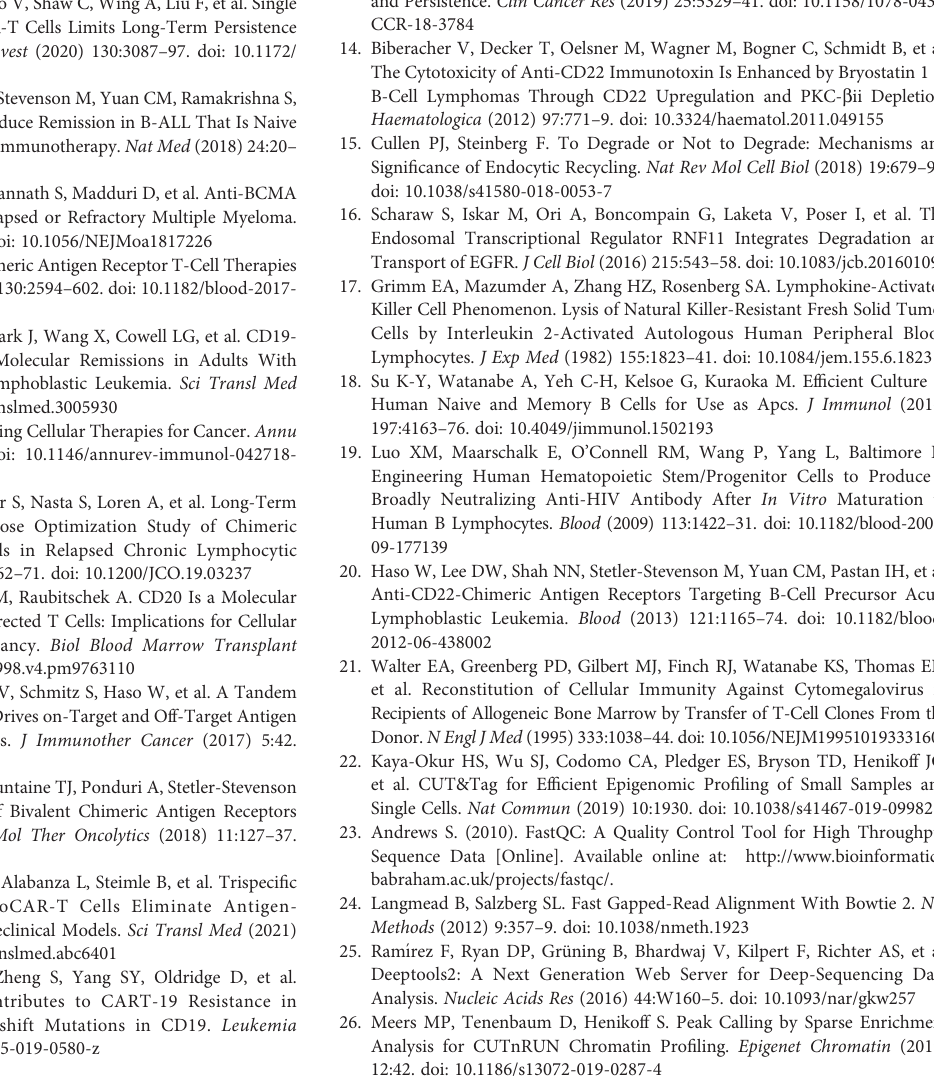
signal from Cut&Tag analysis and the second tab lists differential expression between bryostatin-treated and control (non-treated) leukemia cells. The global tab contains the peak ID (column A), chromosome (column B), start and end sequence number (C,D), annotation (E), distance to transcription start site (TSS) (F), gene name (G), gene description and type (H,I). Signal for the cell lines, in triplicate, analyzed without bryostatin (J-L) with bryostatin (M-O), normalized signal by DESeq2 without bryostatin (P-R), normalized signal by DESeq2 with bryostatin (S- U); column V is not utilized, but gives signal intensity mean across all samples, column W, log2 fold-change (without bryostatin versus with bryostatin, and thus negative in value); column X, standard error of log2 fold-change; column Y, standard error of the log2 fold-change, Wald statistic; column Z, Wald test p-value; column AA, Benjamini-Hochberg adjusted p-value. All stats were calculated within the DSeq2 package. Thus, ST2 contains the following tabs: K4me2NALM6 K4me3NALM6_|FC|>4_P<0.001_green (fold change greater than 4, indicated p value) K4me3NALM6 K4me3NALM6_|FC|>4_P<0.005_green K4me2REH K4me2REH_|FC|>4_P<0.001_green K4me3REH